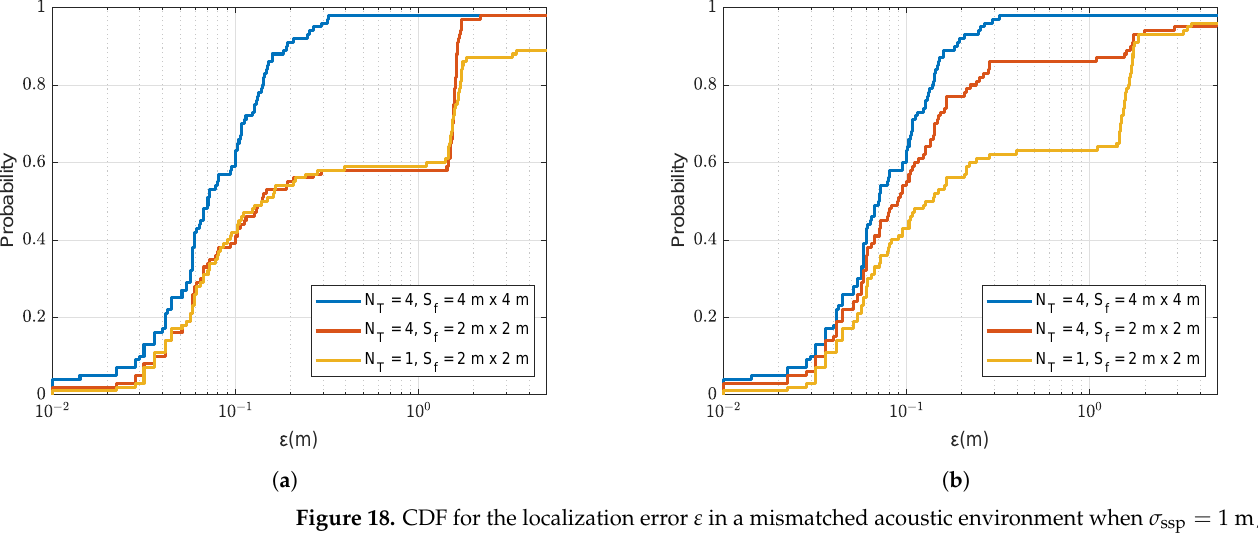
Figure 18. CDF for the localization error ε in a mismatched acoustic environment when σ ssp = 1 m/s as shown in Figure 3: ( a ) Depth is unknown; ( b ) Depth is known. N T = 4; N max = 4, nine points are removed after finding the next coarse AF maximum; the refinement steps, F r = F d = 0.1 m; the